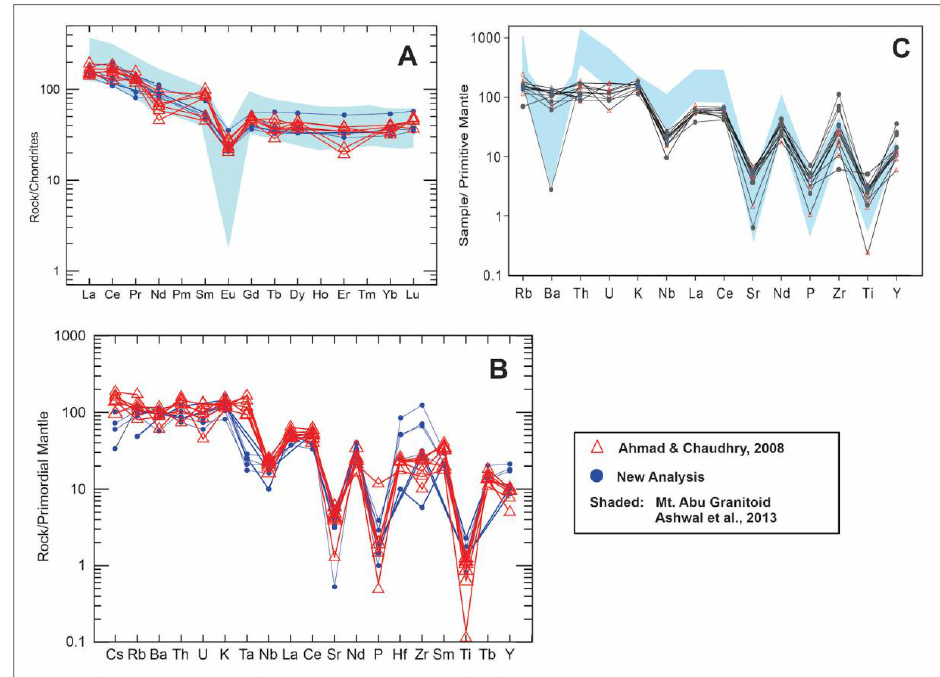
Figure 9. ( A ) Chondrite-normalized REE contents of the Wadhrai granite. Normalizing values are after [39]. ( B ) Primordial mantle normalized spidergram for a wide range of trace elements in the Wadhrai granite. Normalizing values are after [32]. ( C ) Selected trace elements normalized to primordial mantle of [40]. Superposed shaded pattern in A and C is the field of analyses from Mt. Abu granitoid of the MIS in Rajasthan after [9]. The patterns of the analyses from Mt. Abu and Wadhrai are remarkably similar except for Ba, Th and